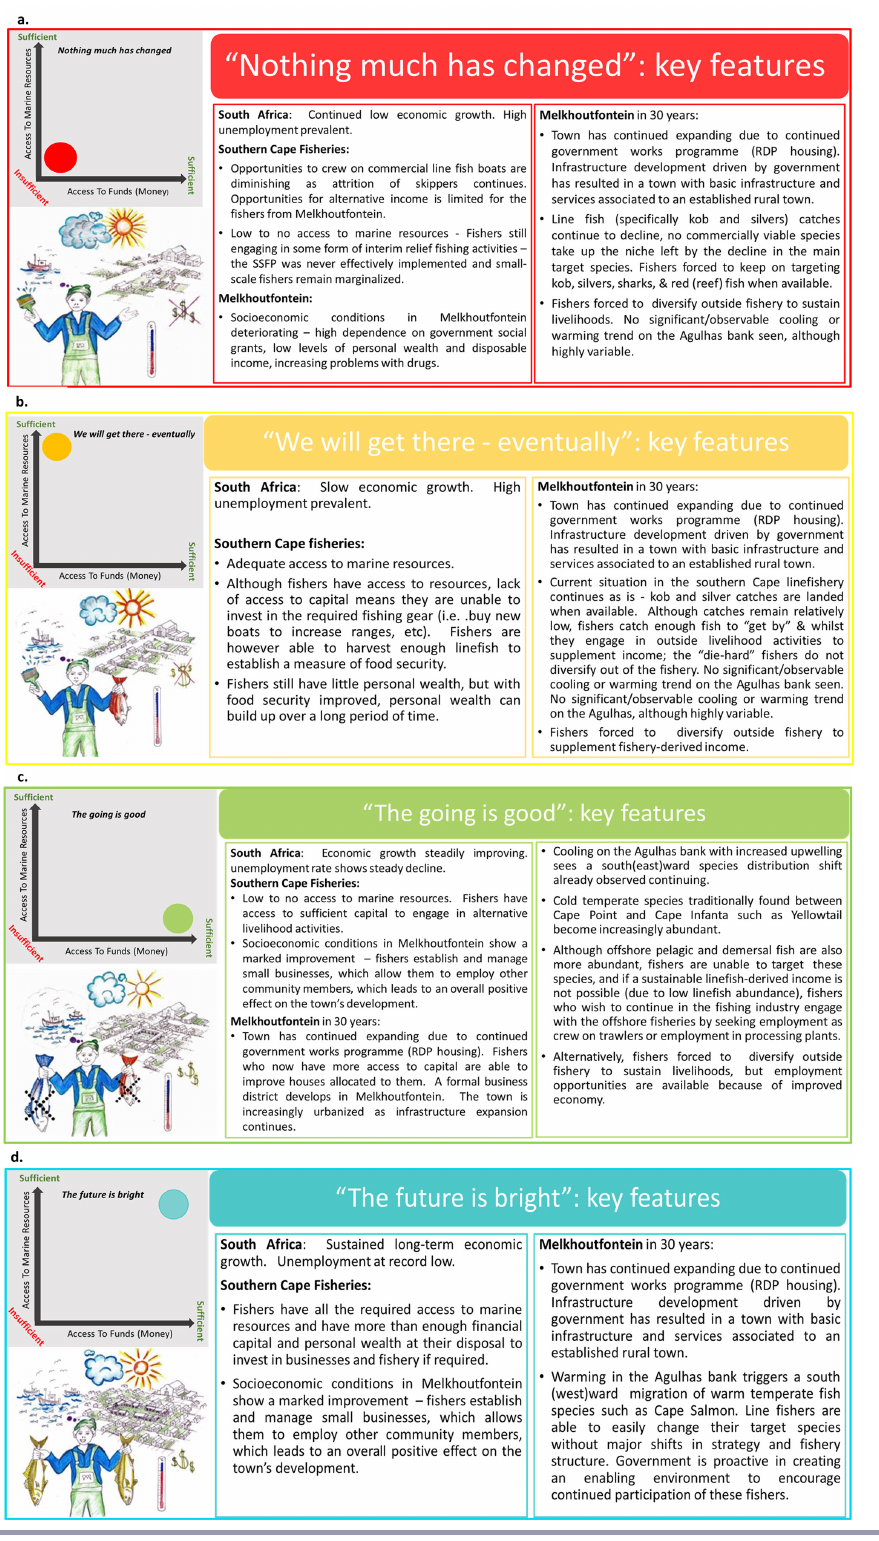
Fig. 7 . The four final scenarios (a) “Nothing much has changed,” (b) “We will get there - eventually,” (c) “The going is good,” and (d) “The future is bright.” The upper-left panel shows the position on the original plane with an artistic depiction of the story in the lower-left panel. The right panel depicts key features of each of the